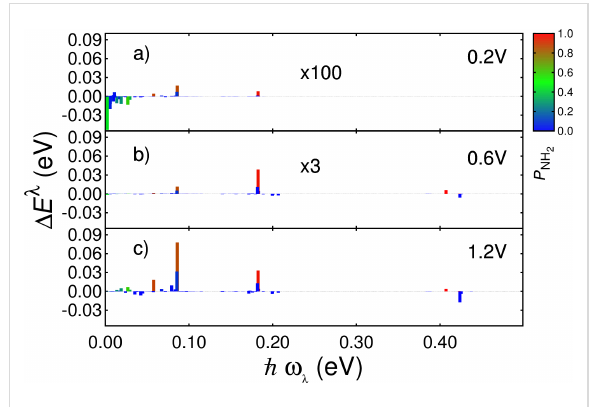
Figure 6: Change in energy stored in each vibrational mode when setting the contributions of the NH 2 group to zero in the spectral func- tions of the CA junction at (a) 0.2 V, (b) 0.6 V and (c) 1.2 V for J = 1 × 10 11 Hz. The color bar indicates to which extent the vibrational modes are localized on the adsorbate, as given by Equation